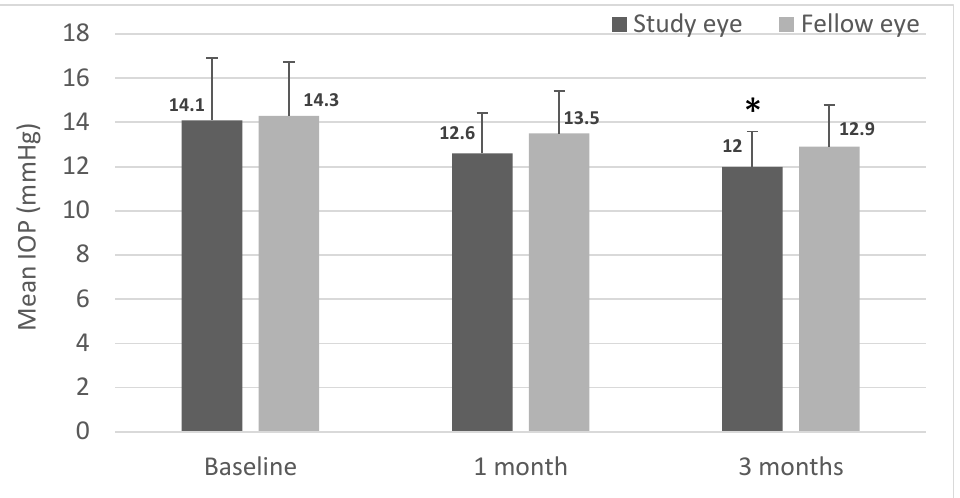
Figure 2. Mean intraocular pressure (IOP) in study and fellow eyes over 3 months. Intraocular pressure (IOP) was measured by Goldmann applanation tonometry preoperatively (baseline) and at months 1 and 3 postoperatively (n = 24). Data are expressed as mean ± standard deviation (* p < 0.05 from baseline; paired t -test).